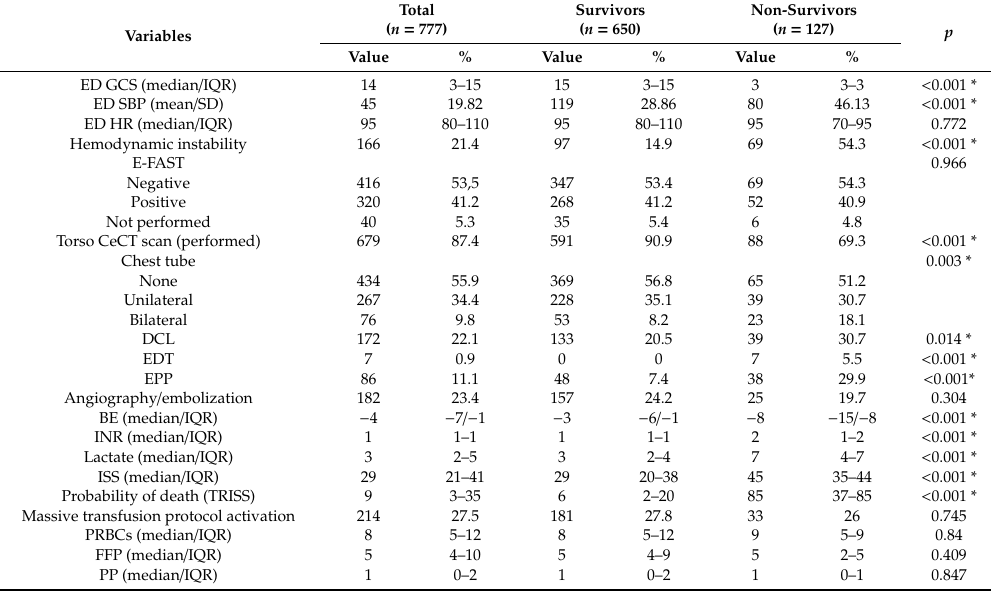
Table 2. Patient characteristics, diagnostics, and procedures in the emergency department / operating room. Comparison between survivors and non-survivors.